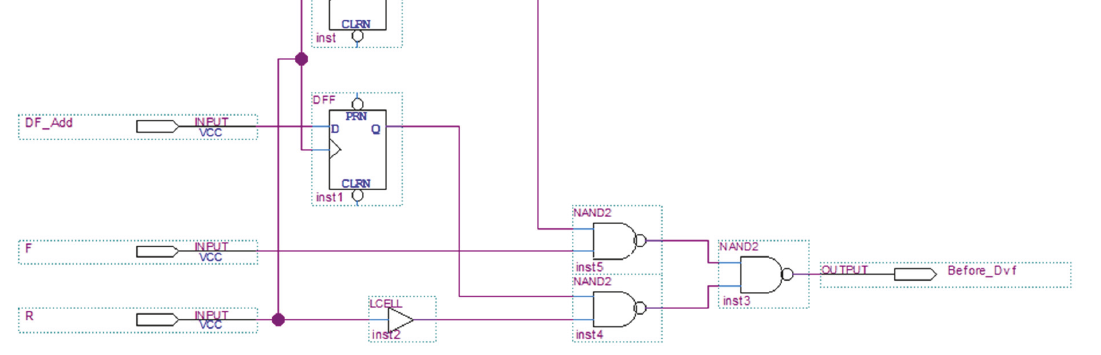
Figure 8: Schematic of the control module.